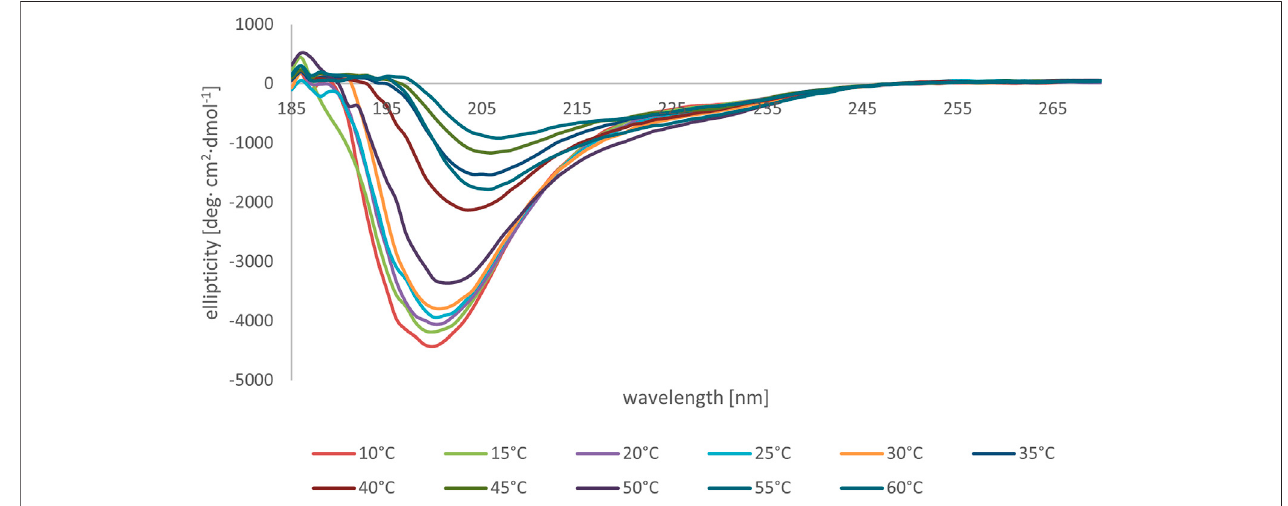
FIGURE 6 | CD spectra of peptide MBP (76 – 116) (2) in PBS at various temperatures.